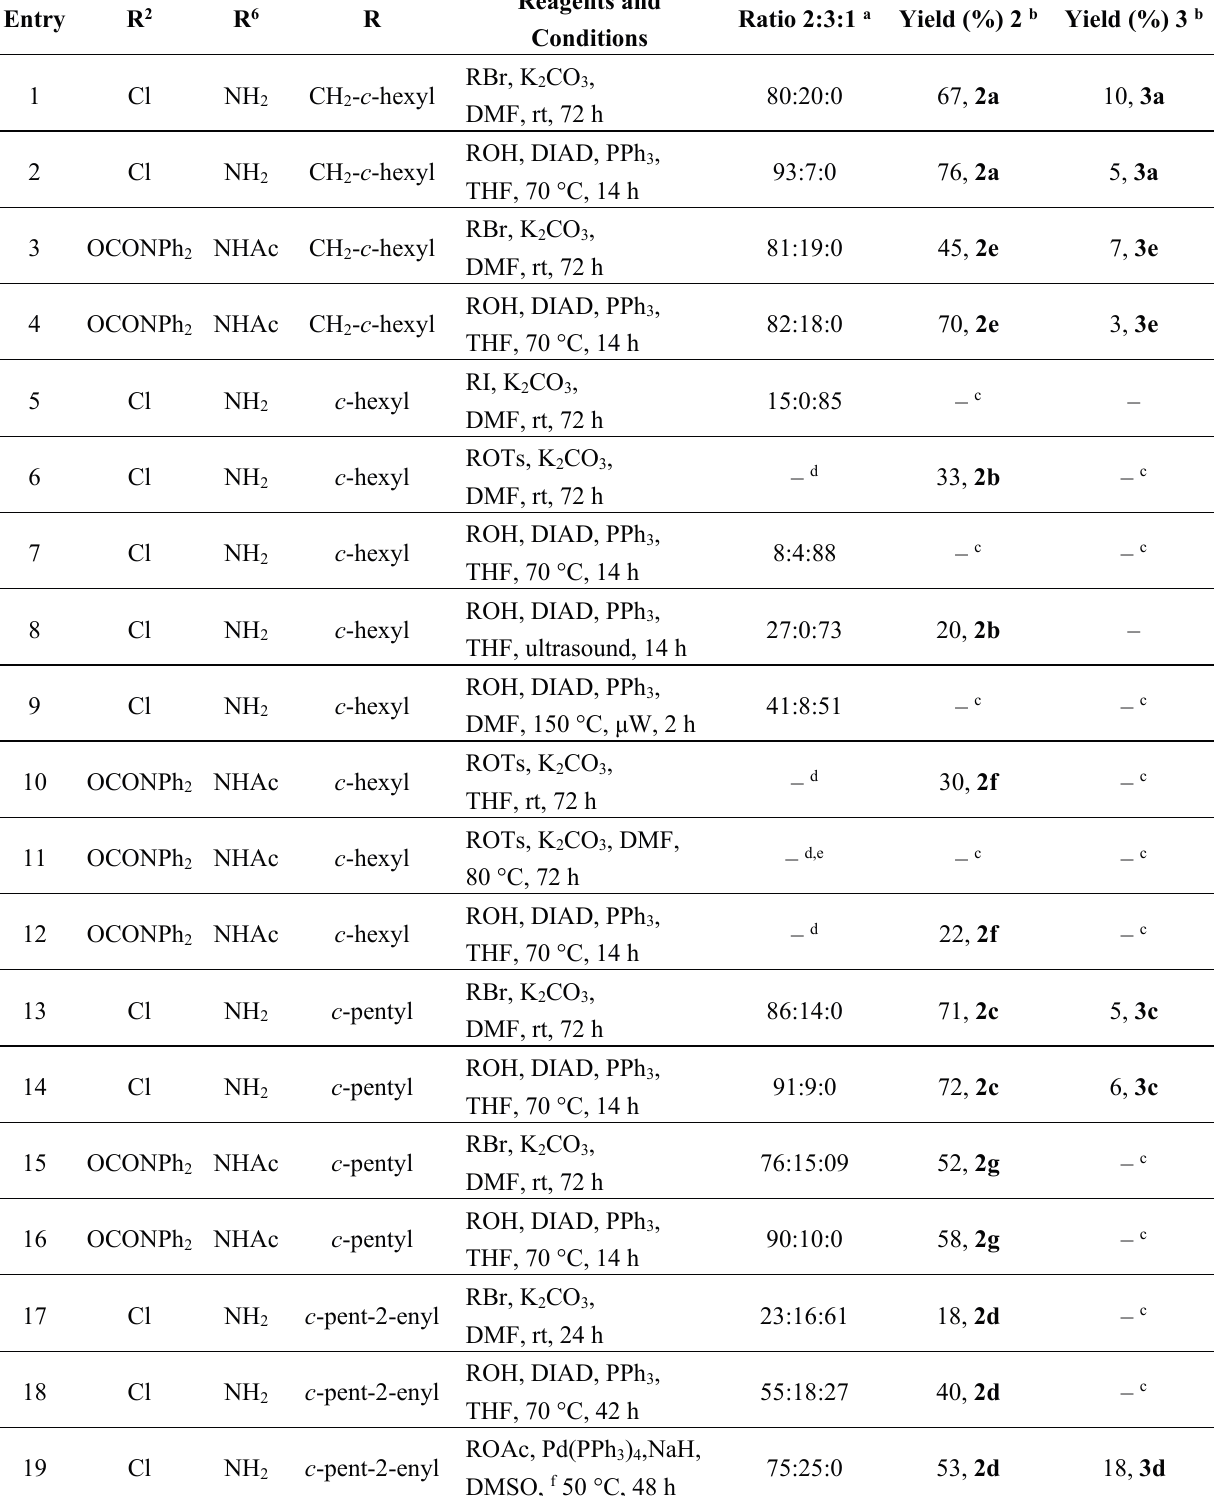
Table 1. N -alkylation of guanine precursors 1a and 1b